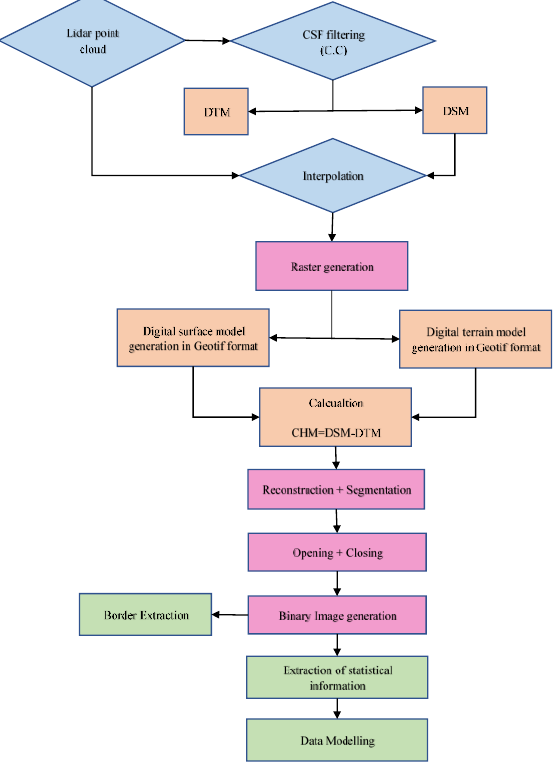
Figure 2 . Flow chart of the process of individual tree extraction and